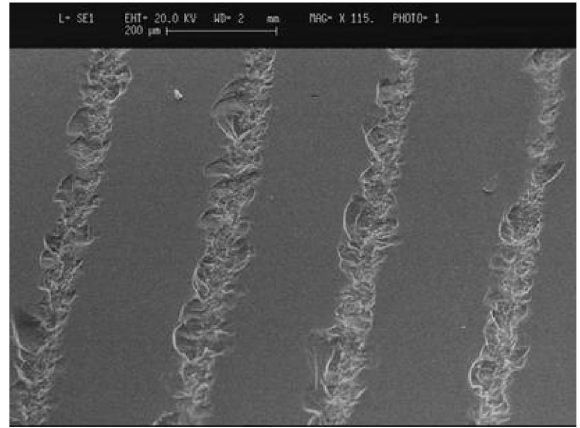
FIG. 2. Surface fragment of one of the manufactured crystal undulators seen by a microscope.